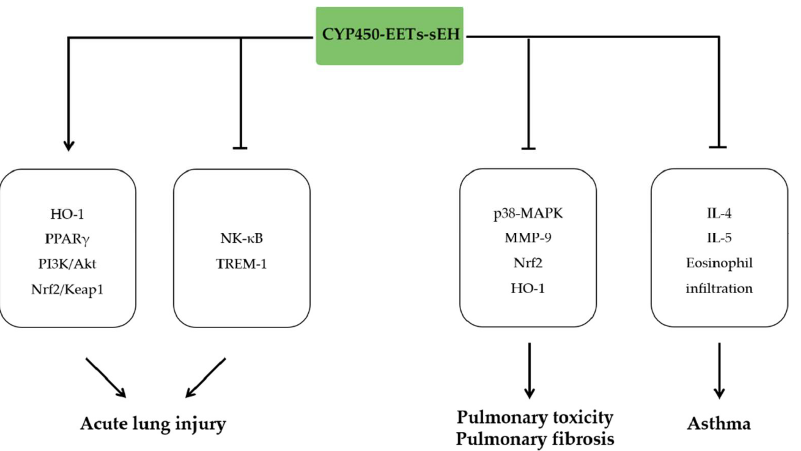
Figure 6. The anti-inflammatory effects of EETs in respiratory diseases. EETs ameliorate acute lung injury by activating HO-1, PPARγ, PI3K/AKT, and Nrf2/Keap1 signaling pathways and inhibiting NF-κB and TREM. EETs attenuate pulmonary toxicity and pulmonary fibrosis by inhibiting Nrf2, p38-MAPK, and HO-1 signaling pathways. EETs also alleviate asthma by inhibiting eosinophil infiltration and IL-4 and IL-5 expression.